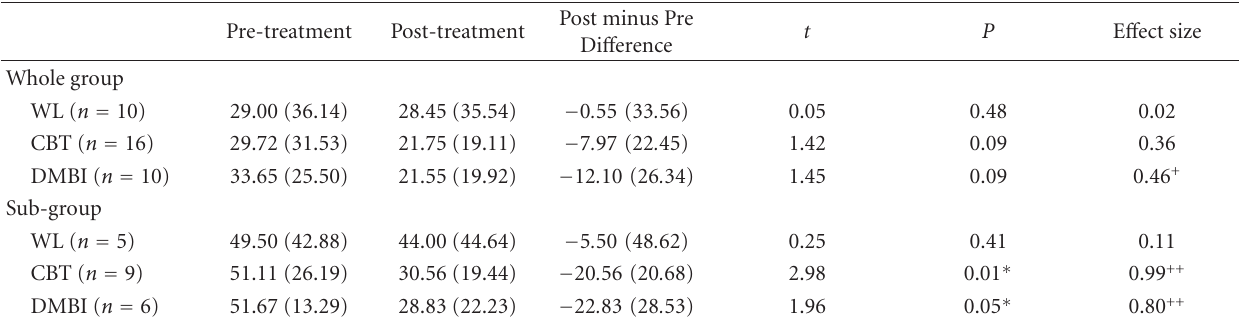
Table 5: Wake time after sleep onset (minutes) at pre- and